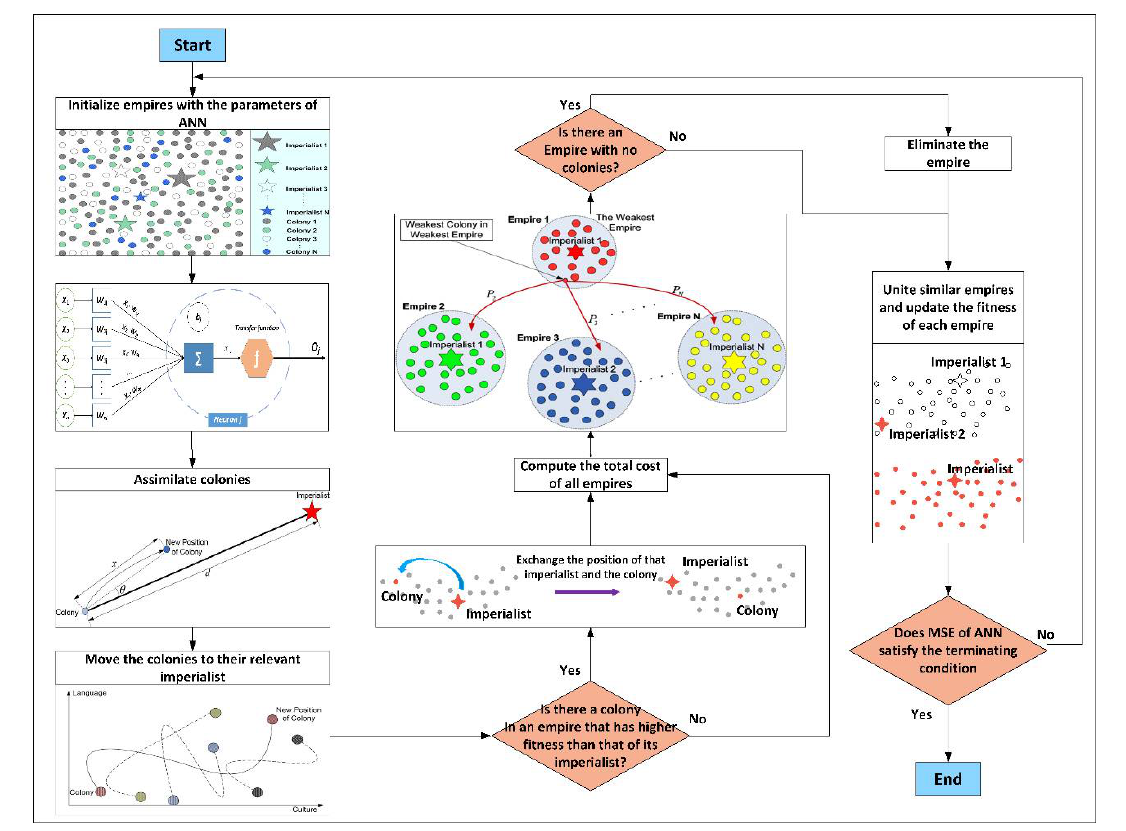
Figure 5. ICA-ANN